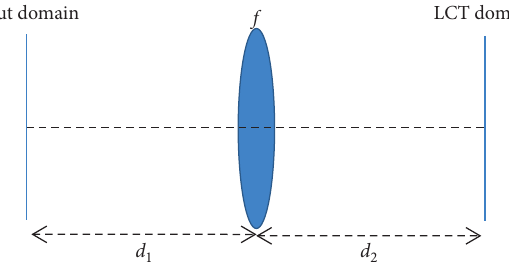
Figure 2: Representation of single lens LCT.